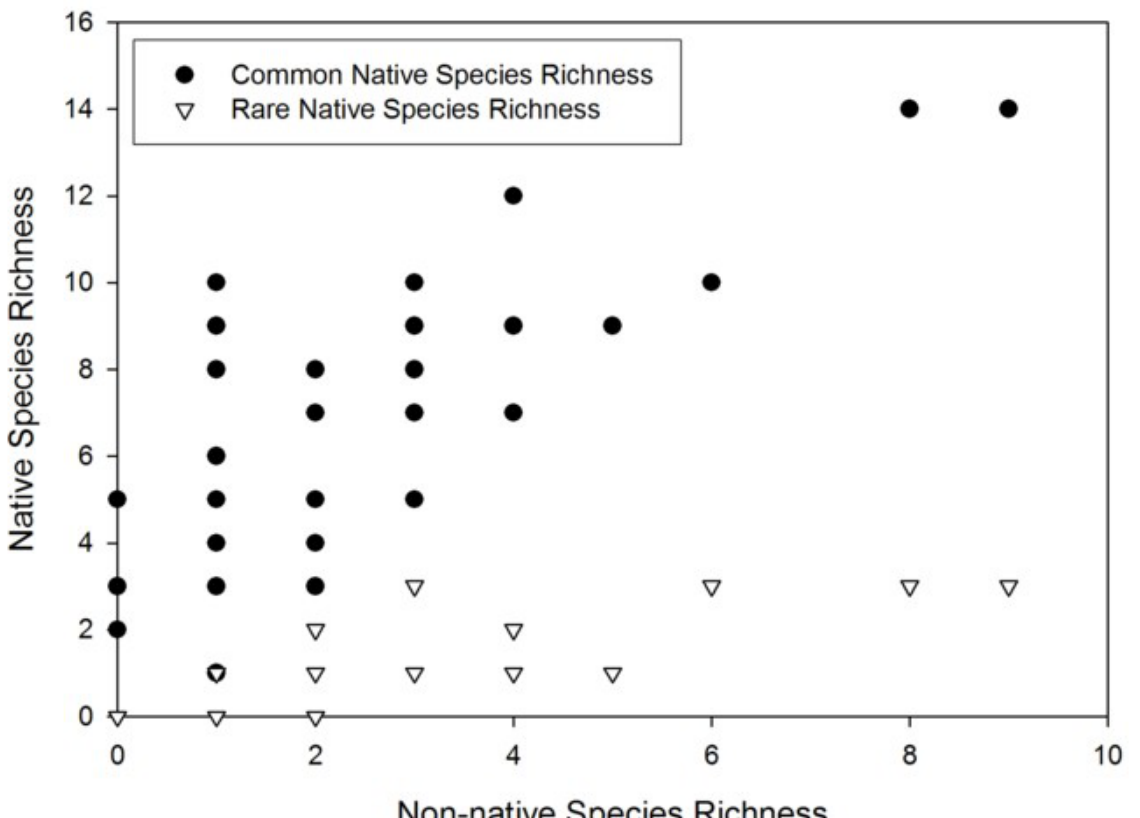
Fig. 4. Scatterplots of the number of common native and rare native species of ants compared with the number of non-native ants at 46 habitat patches in the Lower Florida Keys. Both relationships were highly significant ( p <